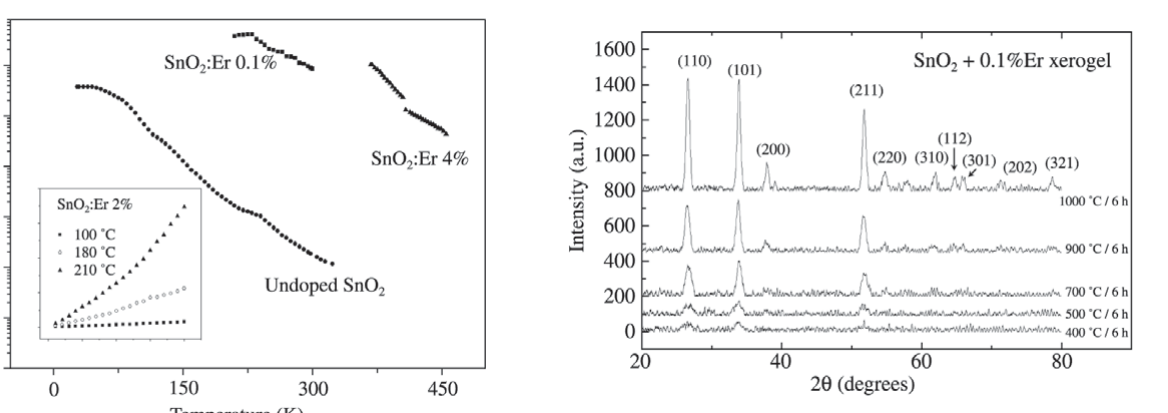
Figure 3. X-ray diffraction data for SnO of annealing temperature. Lines separated for better Table 1. Average particle size of SnO